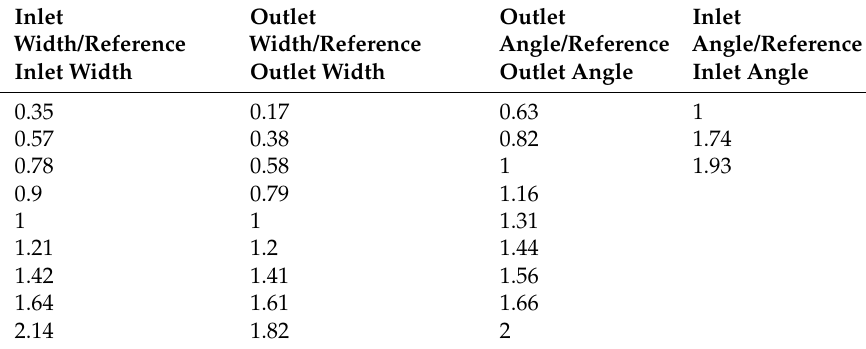
Table 2. List of the different geometry ratios